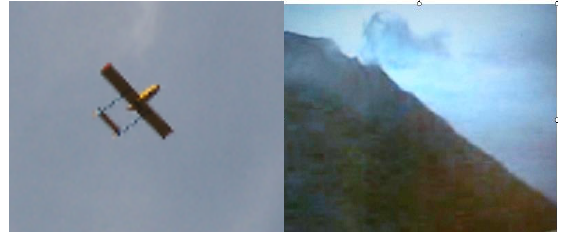
Figure 1. Butterfly radio controlled UAV approaching Stromboli top craters on 2004 flight (left) and pilot camera view (right) of the Stromboli volcano gas plume (Saggiani,